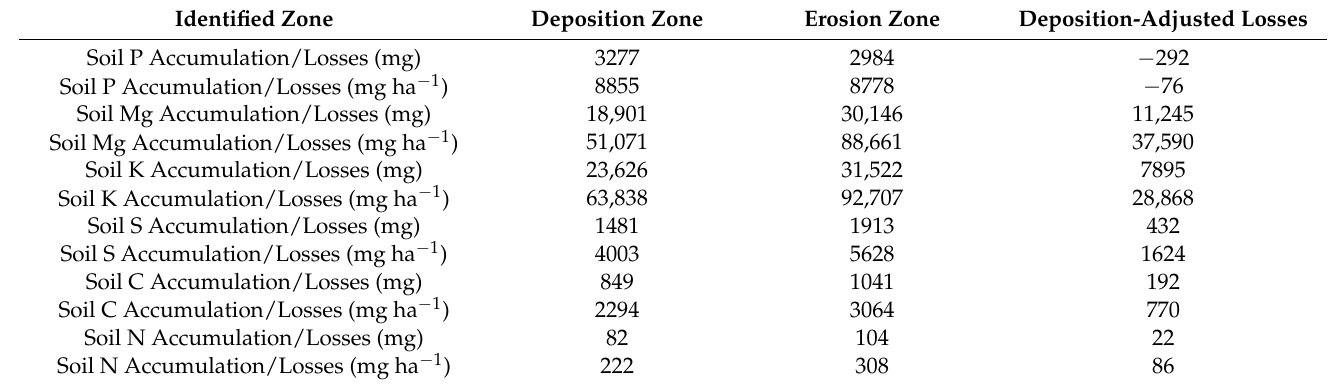
Table 5. Accumulation and losses of P, Mg, K, S, C, and N associated with grassland tillage and reseeding-induced sediment movement. Included is an adjusted representation of nutrient losses assuming identified deposition values correspond to deposition of eroded